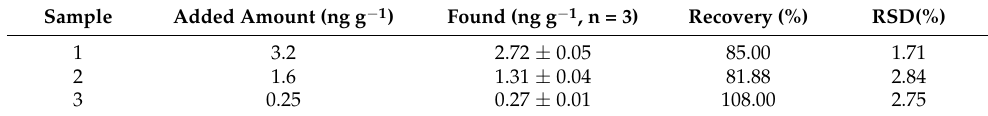
Table 2. Performance of the method in the spiking experiment in blank fish